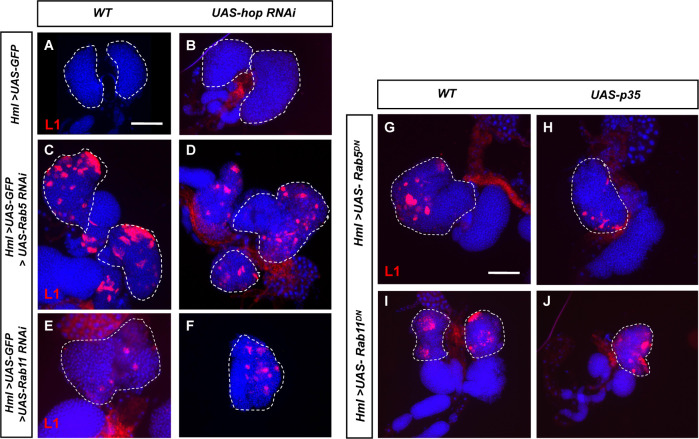
Knocking down hop or blocking apoptosis did not repress aberrant lamellocyte differentiation.Knocking down hop (A–F) or overexpressing UAS-p35 (G–J) failed to repress the aberrant lamellocyte differentiation in Hml>UAS-GFP>UAS-Rab5/11 RNAi or Hml>UAS-Rab5/11DN lymph glands. Scale bar: 50 μm.